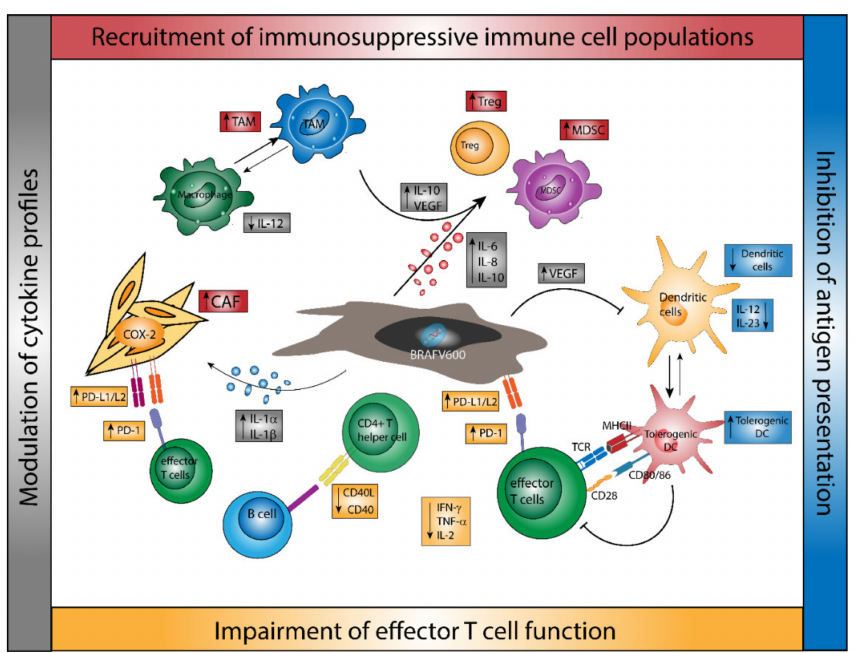
Figure 1. Immunological modulations of the tumor microenvironment in BRAF V600 -mutated melanoma. BRAF V600 -mutated melanoma is characterized by constitutive ERK activation, which results in an elevated release of immunomodulatory mediators that in turn affect both constituents of the microenvironment (TAM, CAF) and infiltrating immune cells (DC, T effector cells) to convey tumor immune evasion. BRAF-mutant melanoma is characterized by a modulation of cytokine profiles, which includes the accumulation of immunosuppressive cytokines such as IL-10 and VEGF, IL-1 β , and lower levels of cytotoxic cytokines such as TNF- α and IFN- γ . Further, BRAFV600-mutated melanoma promote the recruitment of immunosuppressive cell populations such as regulatory T cells and myeloid-derived suppressor cells, favors macrophage polarization towards an M2-phenotype, which may inhibit anti-tumor immunity, and impedes the function of antigen-presenting cells. Ac- cordingly, BRAF-mutant melanoma shows a strong impairment of effector T cell functions, which is conveyed by cell-cell contact-dependent mechanisms of immunosuppressive cell populations, the upregulation of PD-L1 on melanoma cells and cancer-associated fibroblasts, and a cytokine profile favoring the exhaustion and inhibition of effector T cells within the